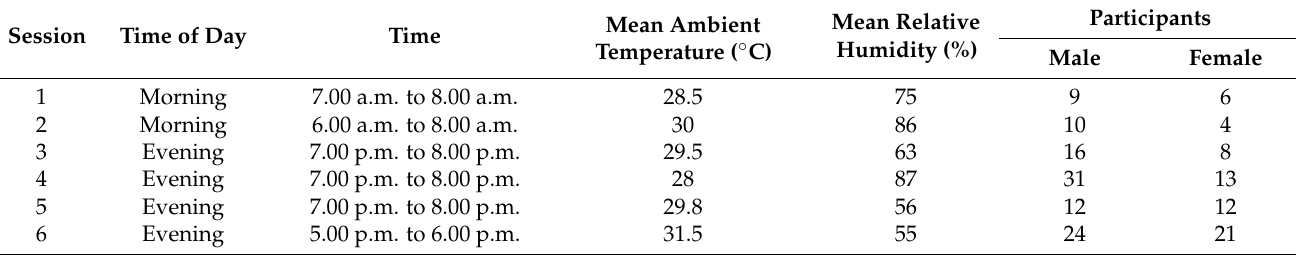
Table 1. Time of day, time, environmental conditions and number of participants during each running session.